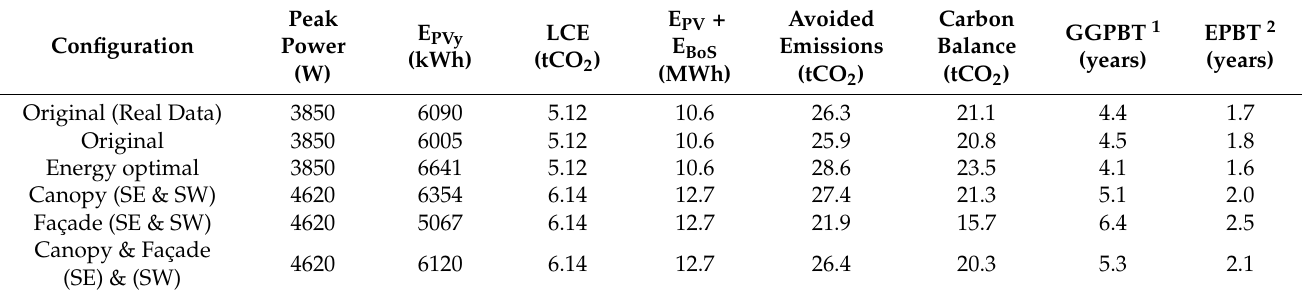
Table 5. Life cycle assessment indicators for the PVSCS layouts under